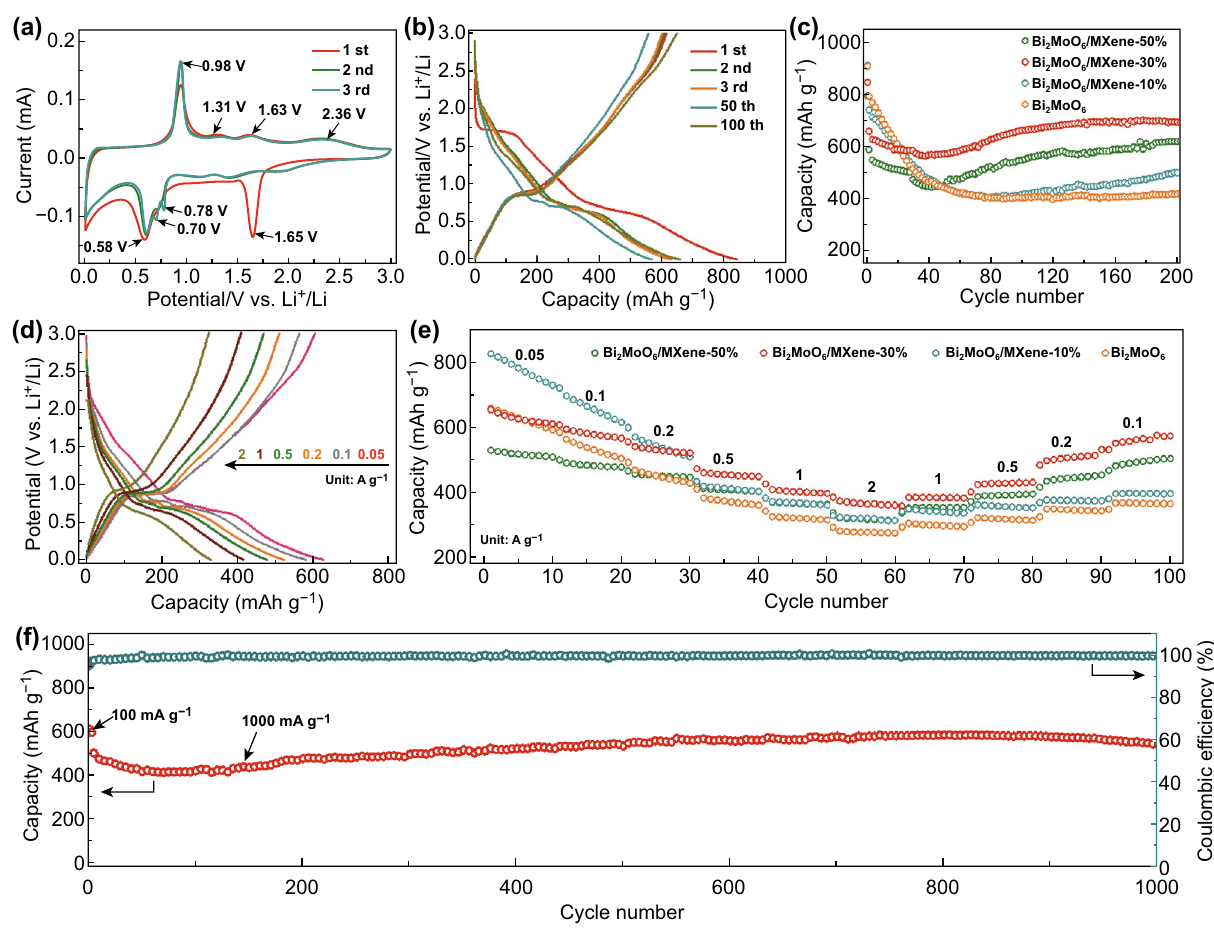
Fig. 5 Electrochemical performance of the Bi 2 MoO 6 /MXene electrodes: a CV curves of Bi 2 MoO 6 /MXene‑30% for the first three cycles at 0.1 mV s −1 . b Charge/discharge profiles of Bi 2 MoO 6 /MXene‑30% at 100 mA g −1 at different cycles. c Cycling performance of Bi 2 MoO 6 / MXene‑50%, Bi 2 MoO 6 /MXene‑30%, Bi 2 MoO 6 /MXene‑10%, and pristine Bi 2 MoO 6 electrodes at 100 mA g −1 for 200 cycles. d Charge/discharge profiles of